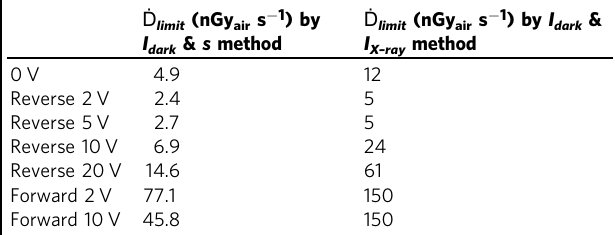
Table 2 # 2 Pb/Au device detection limit of X-ray dose rate _ D limit determined by dark current (